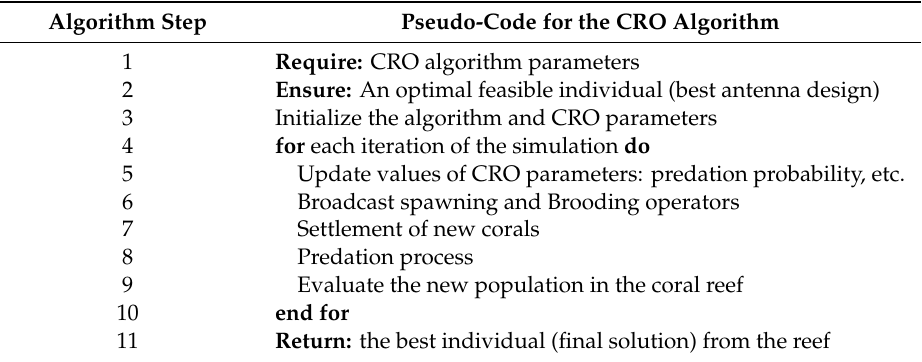
Table 2. Description of the pseudo-code for the Coral Reefs Optimization (CRO)